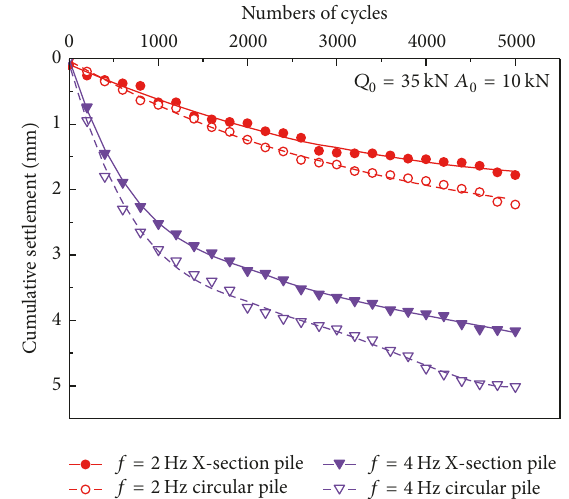
f = 4（Ｔ X-section pile f = 2（Ｔ X-section pile f = 2（Ｔ circular pile f = 4（Ｔ circular Figure 9: Comparison of cumulative settlements of the X-section pile and the circular